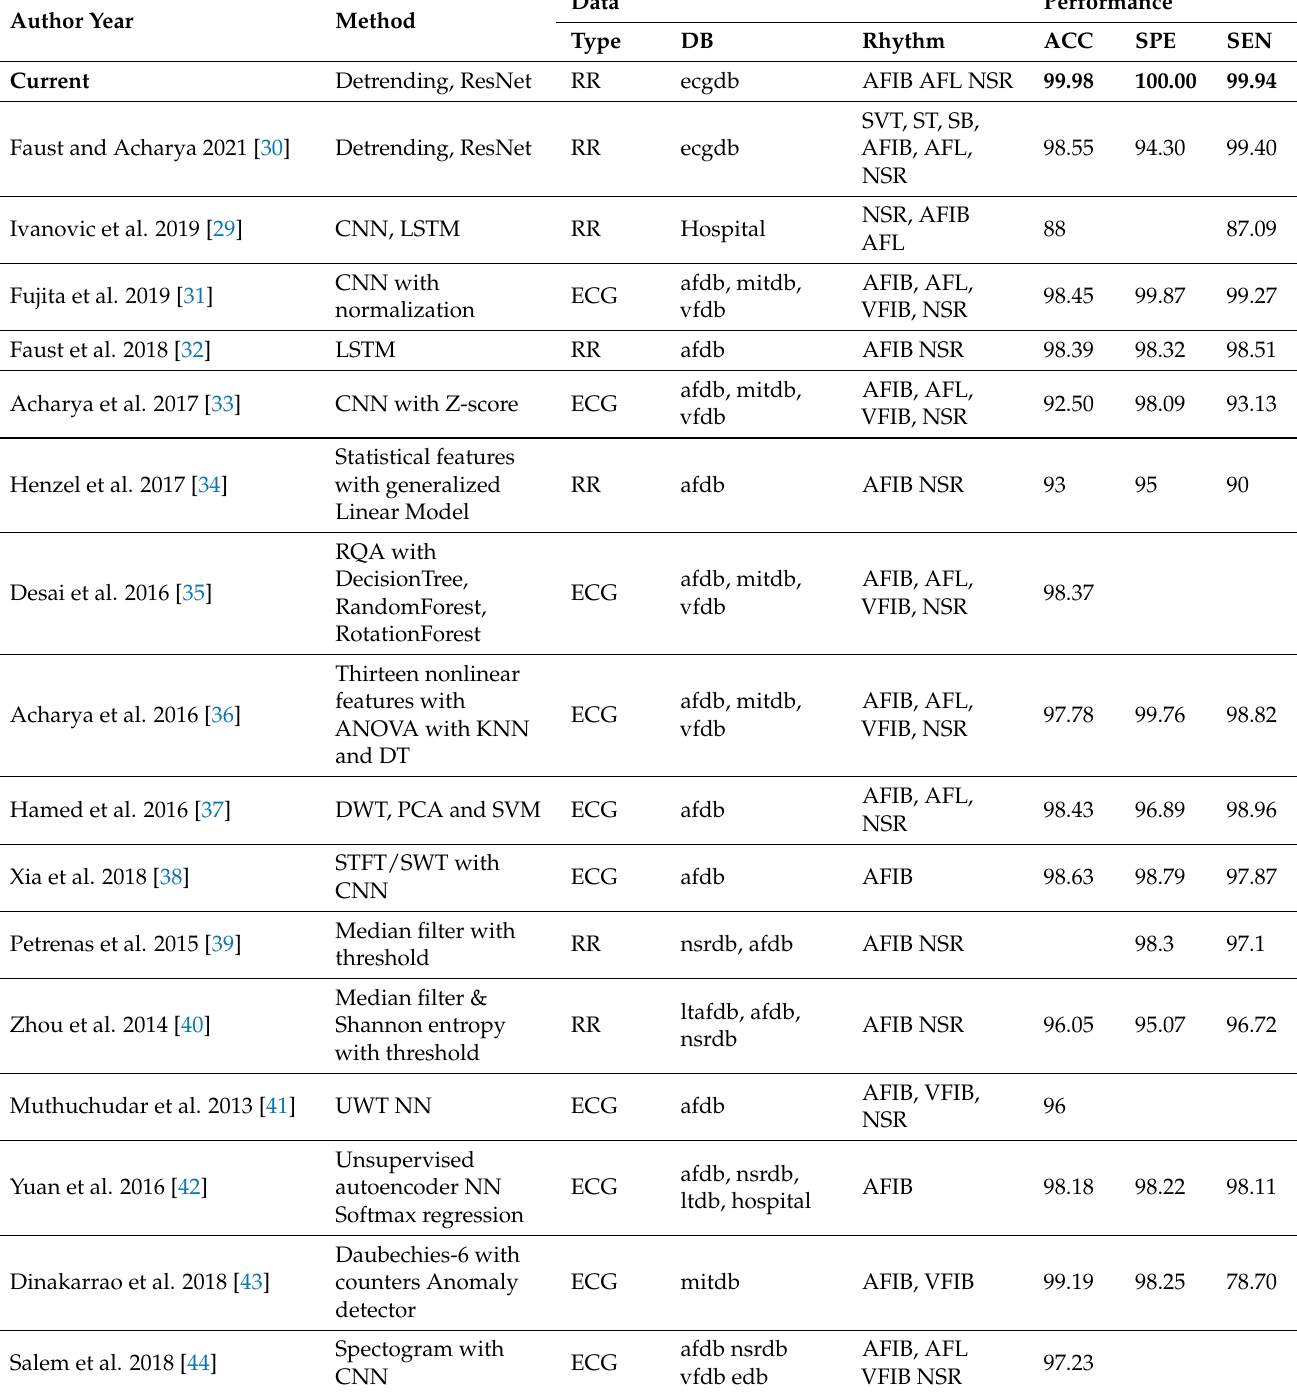
Table 10. Selected arrhythmia detection studies using RR intervals and ECG. pDB used were: MIT-BIH Atrial Fibrillation Database (afdb), MIT-BIH Arrhythmia Database (mitdb), MIT-BIH Malignant Ventricular Arrhythmia Database (vfdb), Creighton University Ventricular Tachyarrhythmia Database (cudb), MIT-BIH Normal Sinus Rhythm Database (nsrdb), MIT-BIH Long Term Database (ltdb), European ST-T Database (edb), and ecgdb. Hospital data come from non-publicly accessible